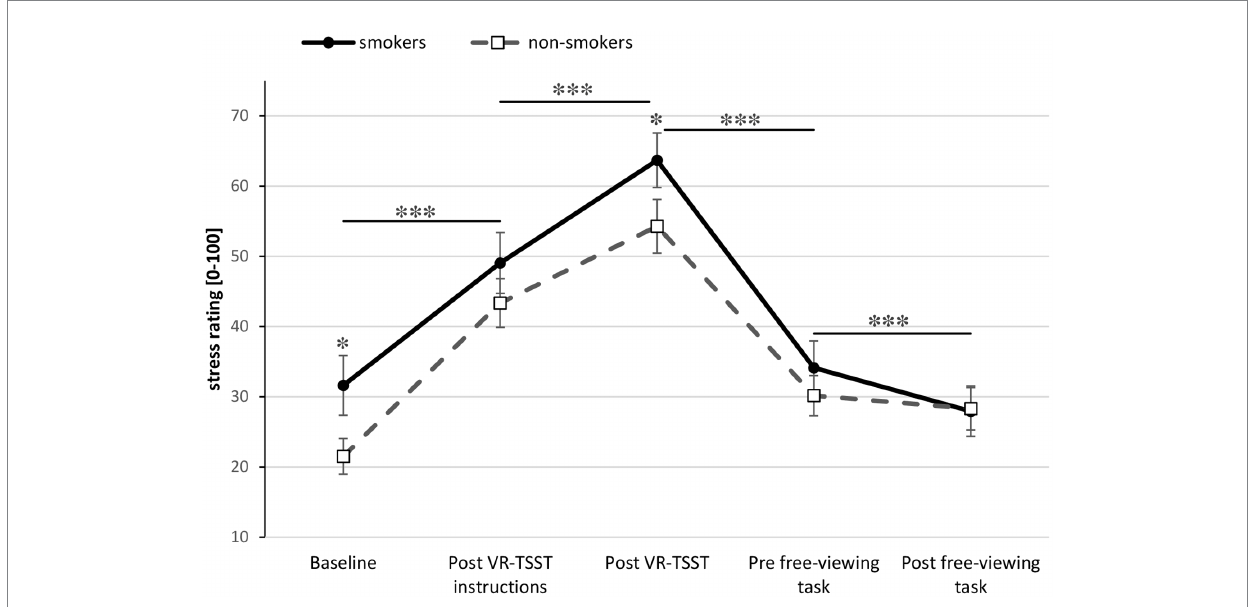
FIGURE 3 Stress ratings during the course of the experiment for smokers ( n = 34) and non-smokers (n = 37). Asterisks indicate significant differences. Error bars show standard